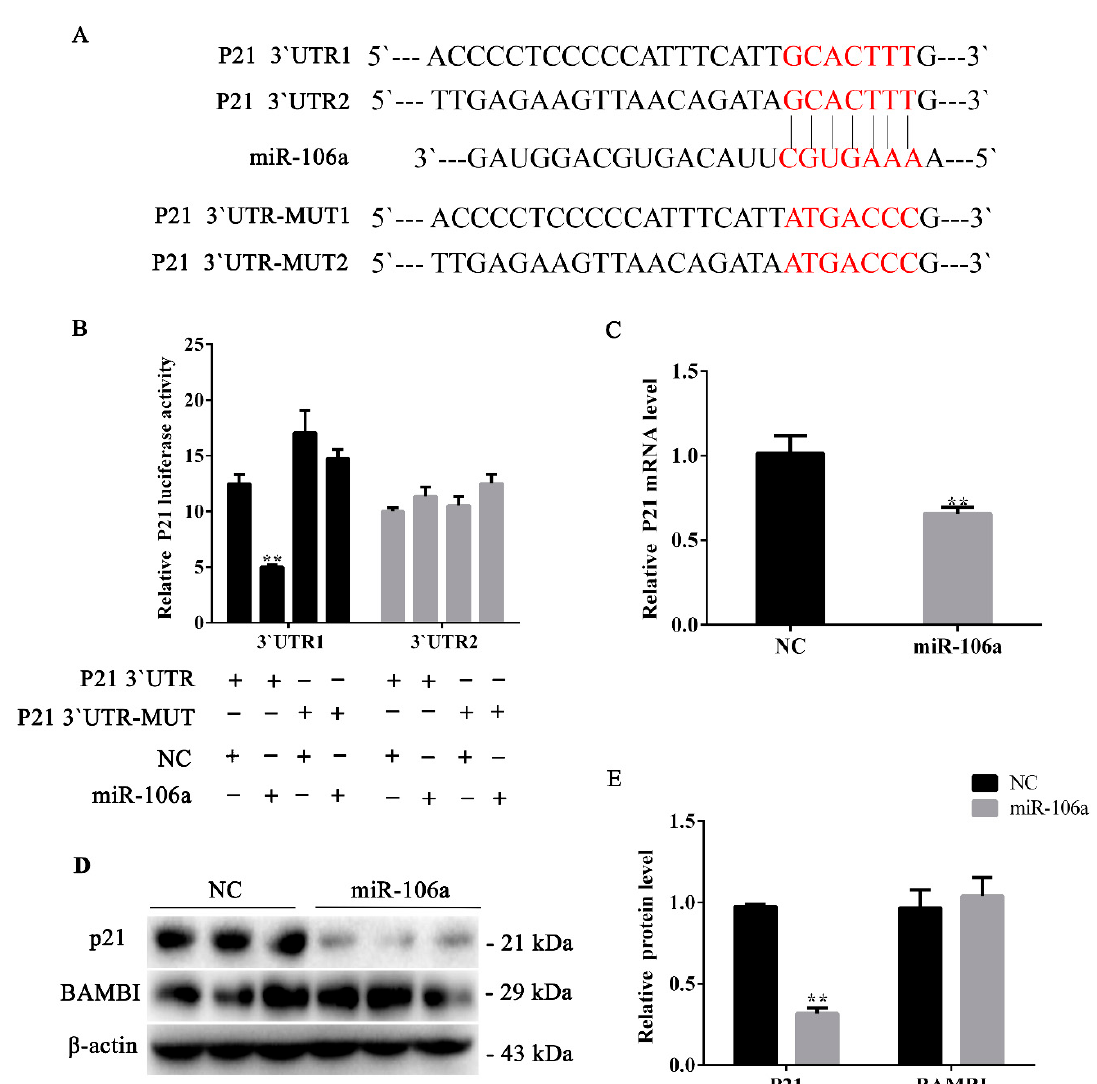
Figure 3. miR-106a can target cyclin-dependent kinase inhibitor 1A (p21) instead of BAMBI in the proliferative phase. (A) The target site of miR-106a within the porcine p21 mRNA 3 ′ UTR and mutational site of p21 3 ′ UTR; (B) a dual-luciferase assay was performed by com-transfection of the miR-106a agomir and wild-type vectors or mutant vectors; relative luciferase activity was represented by Renilla luciferase/firefly luciferase (RLUC/FLUC); (C) the relative p21 mRNA expression levels after treatment with the miR-106a agomir; (D) western blot analysis of p21 and BAMBI protein expression after treatment with the miR-106a agomir; (E) the quantification of p21 and BAMBI protein expression levels. Data are representative of the mean ± SEM of three independent experiments. * p < 0.05, ** p < 0.01.